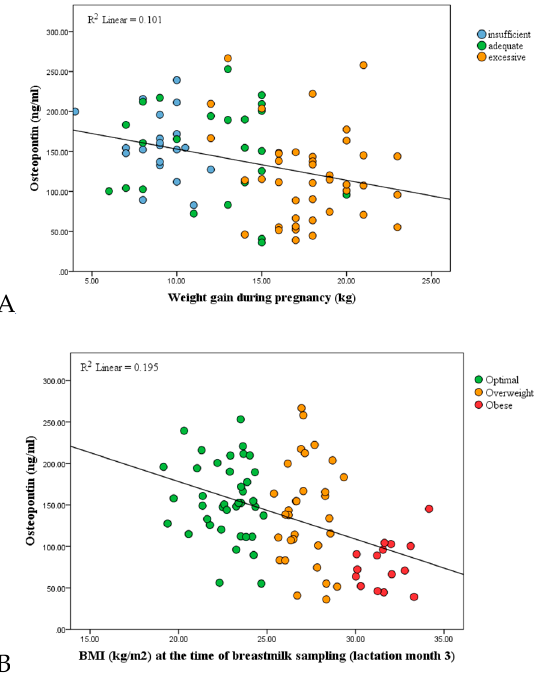
Figure 1. ( A ) Correlation between weight gain during pregnancy and OPN levels in the breast milk of study participants (r = − 0.441, p < 0.05, Spearman correlation). ( B ) Correlation between BMI during lactation and the mothers’ breast milk OPN levels (r = − 0.352, p < 0.05, Pearson correlation). Breast milk OPN concentrations were observed to be significantly lower in mothers who smoked. The mean breast milk OPN levels of individuals who smoked in the pre- pregnancy period were 102.0 ± 41.4 mg/L, a significant reduction compared with the group of mothers who did not smoke 160.4 ± 53.8 mg/L ( p < 0.05). Similarly, mean levels of breast milk OPN were significantly decreased in mothers who smoked during pregnancy or lactation (103.1 ± 50.6 mg/L and 98.3 ± 49.2 mg/L, respectively) compared with non-smoking mothers (143.8 ± 55.9 mg/L and 144.1 ± 55.5 mg/L, respectively) (Table